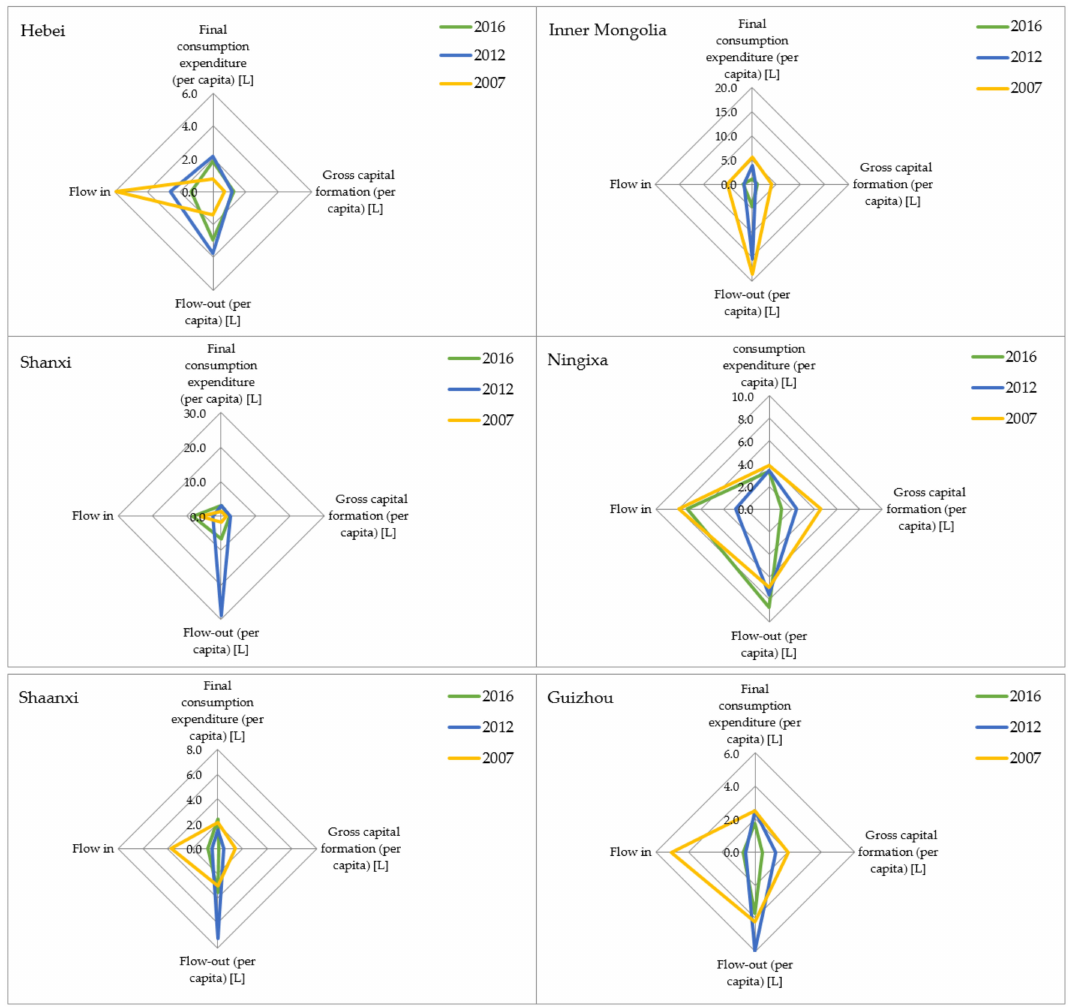
Figure A3. Changes of 4 indicators in 2007, 2012 and 2016 of Group